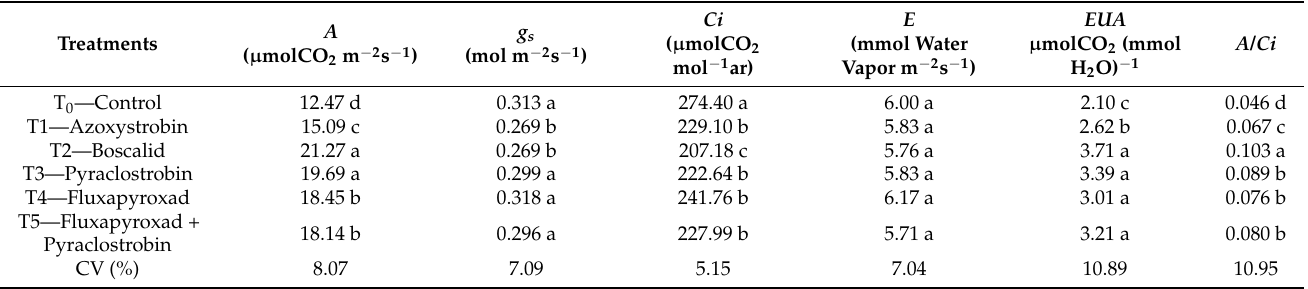
Table 1. CO 2 assimilation rate ( A ), stomatal conductance ( gs ), internal CO 2 concentration ( Ci ), water use efficiency ( WUE ), carboxylation efficiency ( A/Ci ) and transpiration ( E ) of plants of tomato plants treated with fungicides with a physiological